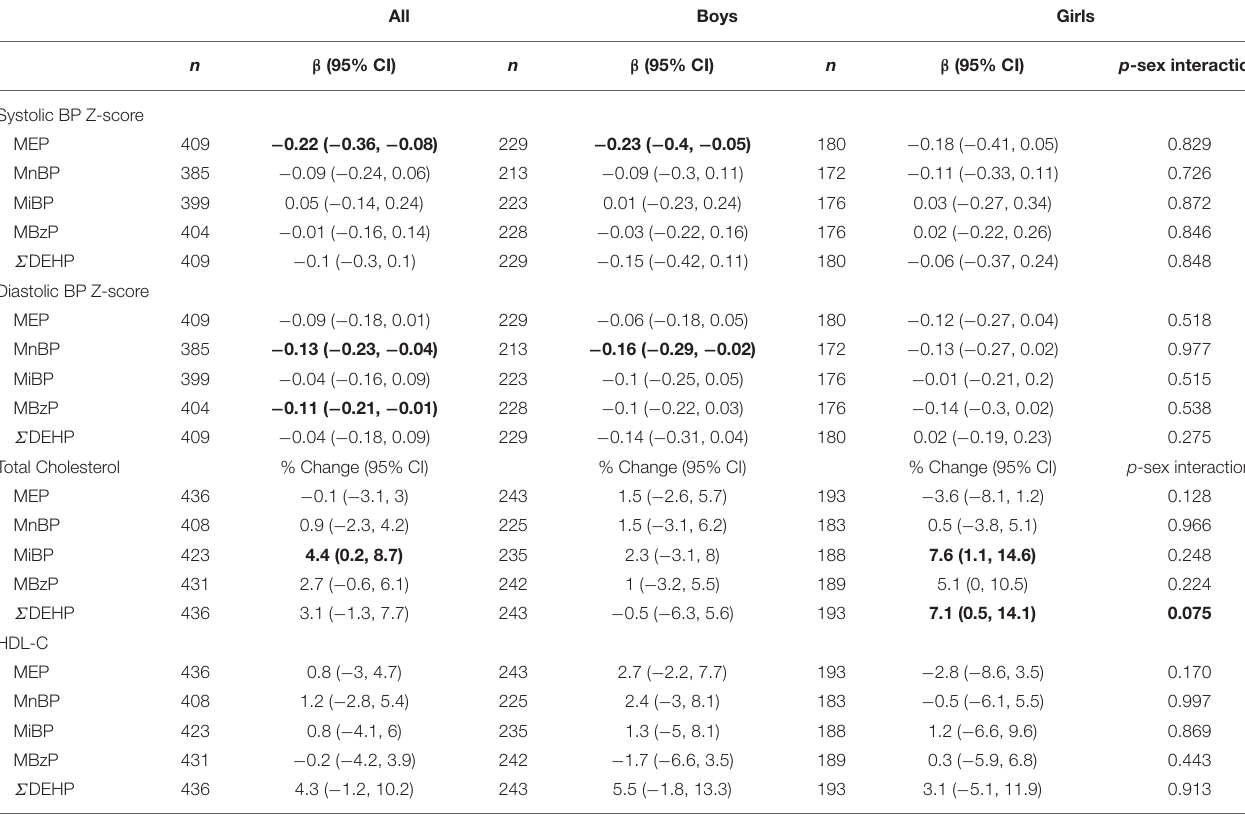
TABLE 4 | Sex-stratified associations between child urinary individual and summed Σ DEHP phthalate metabolites (log 10 Transformed, in µ g/g Creatinine) with lipids and blood pressure levels in children aged 4–6 years.